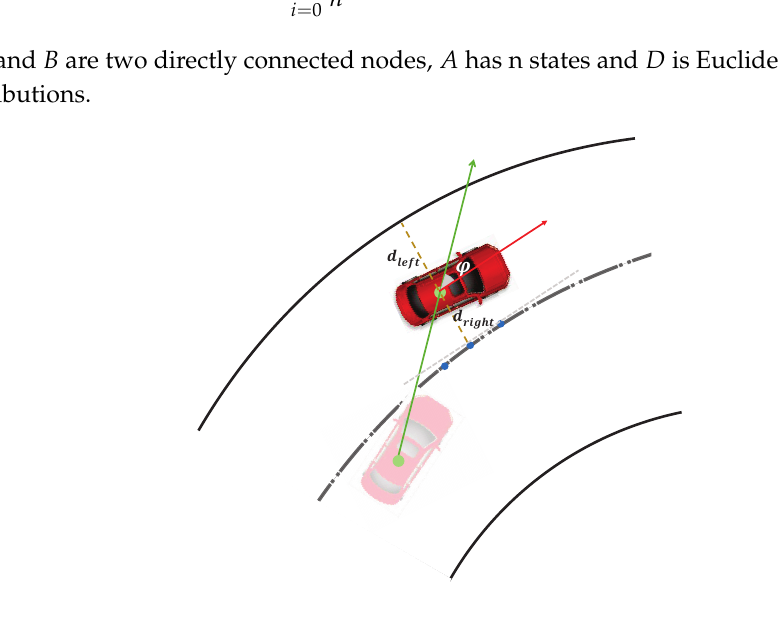
Figure 4. Description of key threshold parameters of the physical-based features: YA and